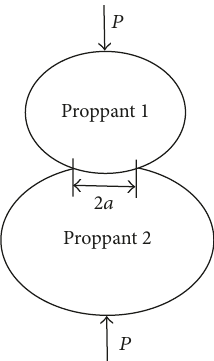
Figure 1: Schematic diagram of contact deformation between proppants.